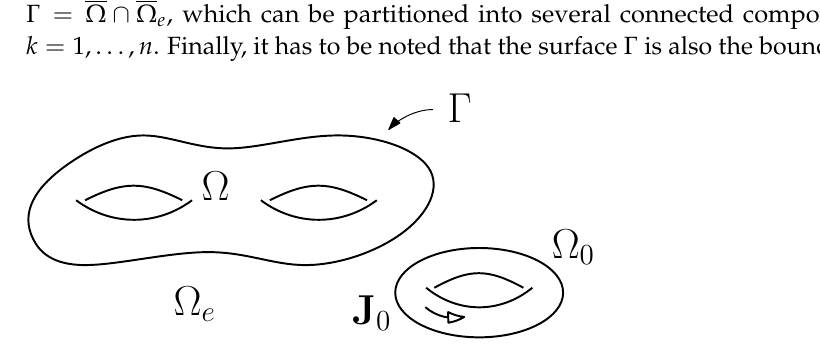
Figure 1. Computational domain for the eddy–current problem with open boundary: Ω is the interior region (possibly multiply-connected), Ω e is the exterior region (which is unbounded), and Ω 0 is the source region (with given current density J 0 ). The interface Γ separates Ω from Ω e